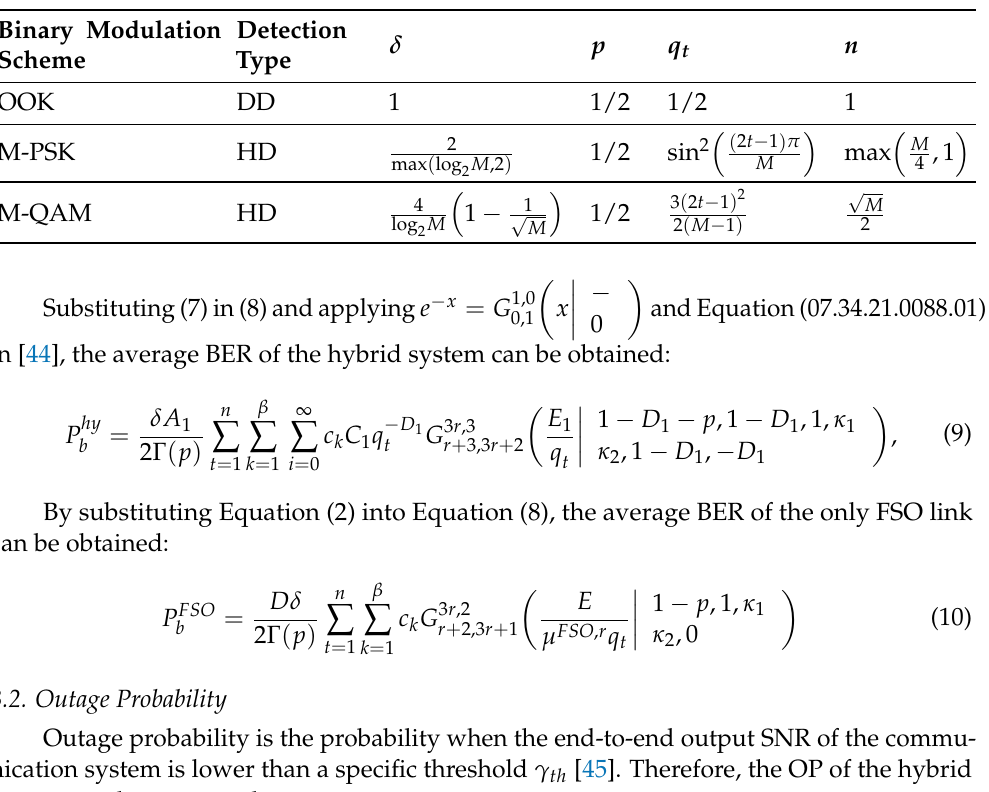
Table 2. Parameters for different modulation